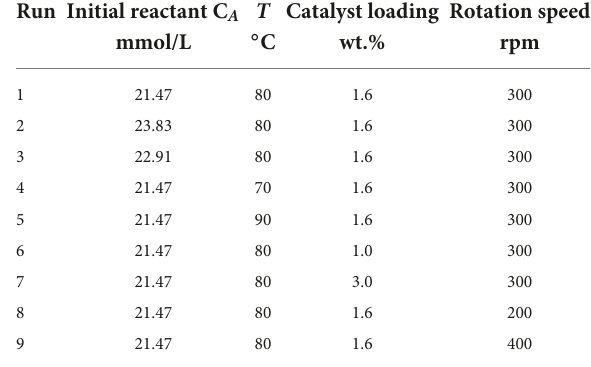
TABLE 1 Experimental matrix for the sesamin